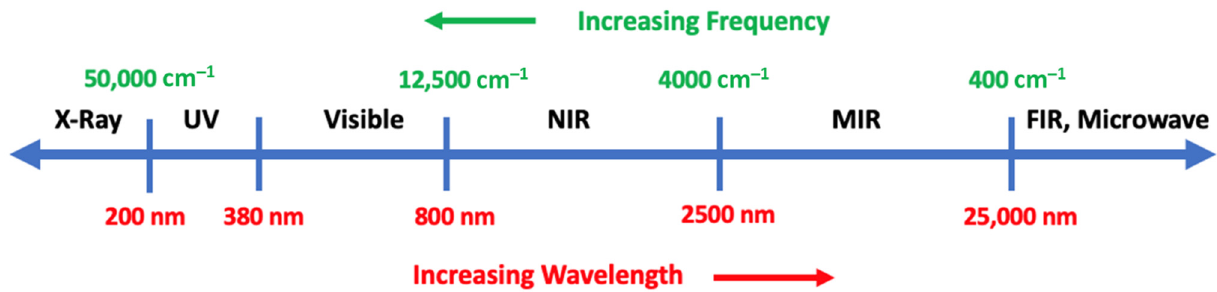
Figure 1. Wavelength range for different optical technologies (adapted from [20,32]).